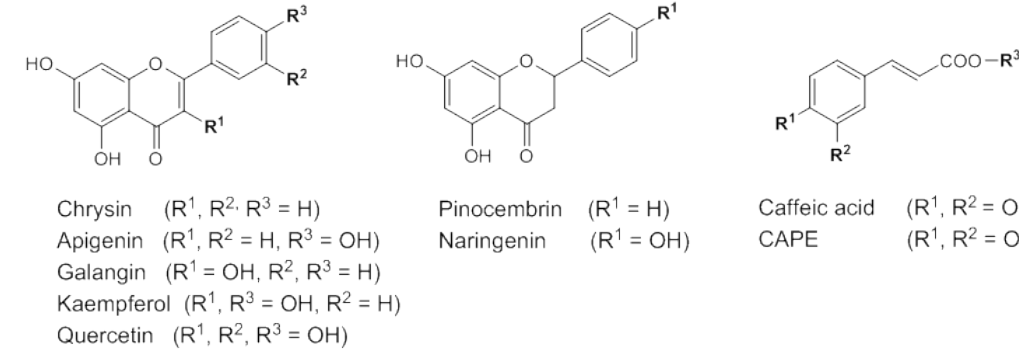
Fig. 1: Structure of the reference